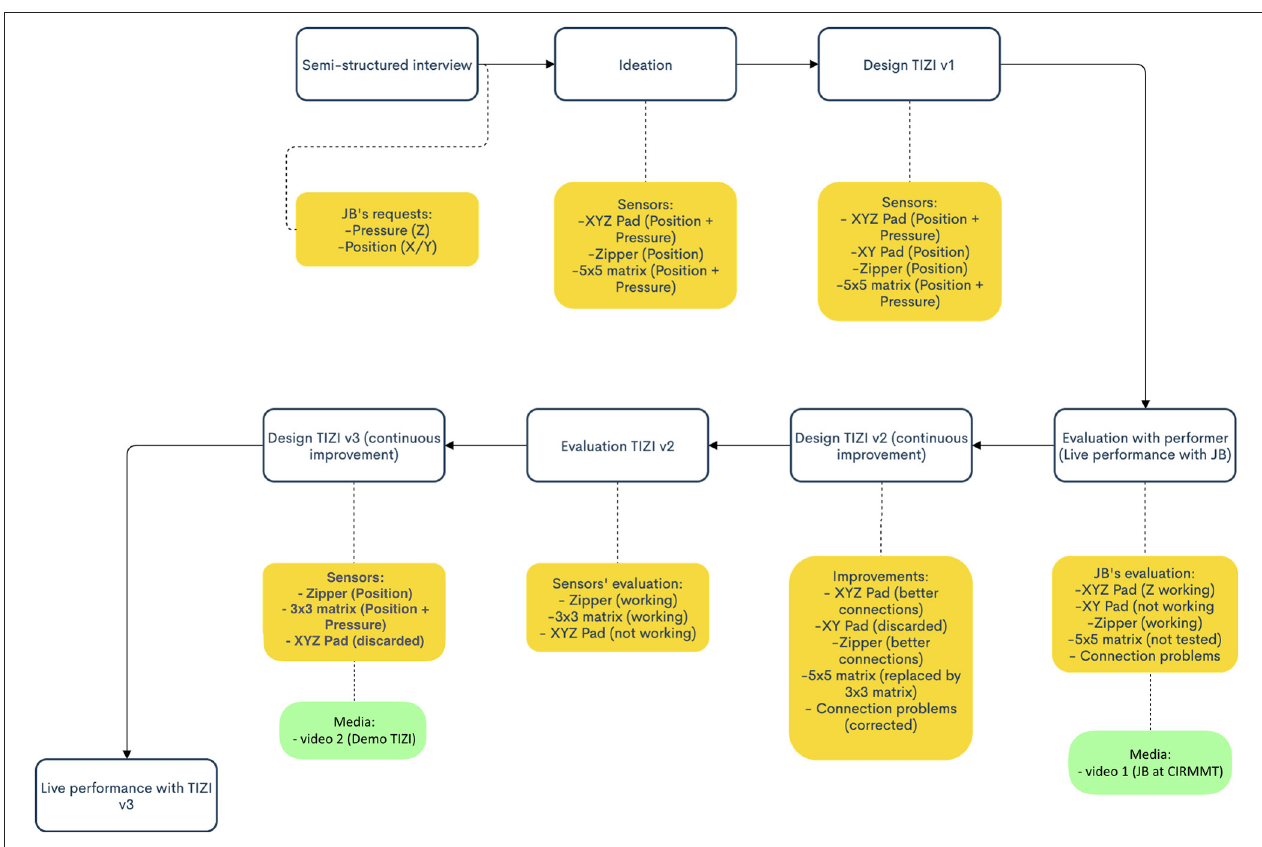
FIGURE 1 | Flowchart of our design trajectory of the TIZI prototypes.